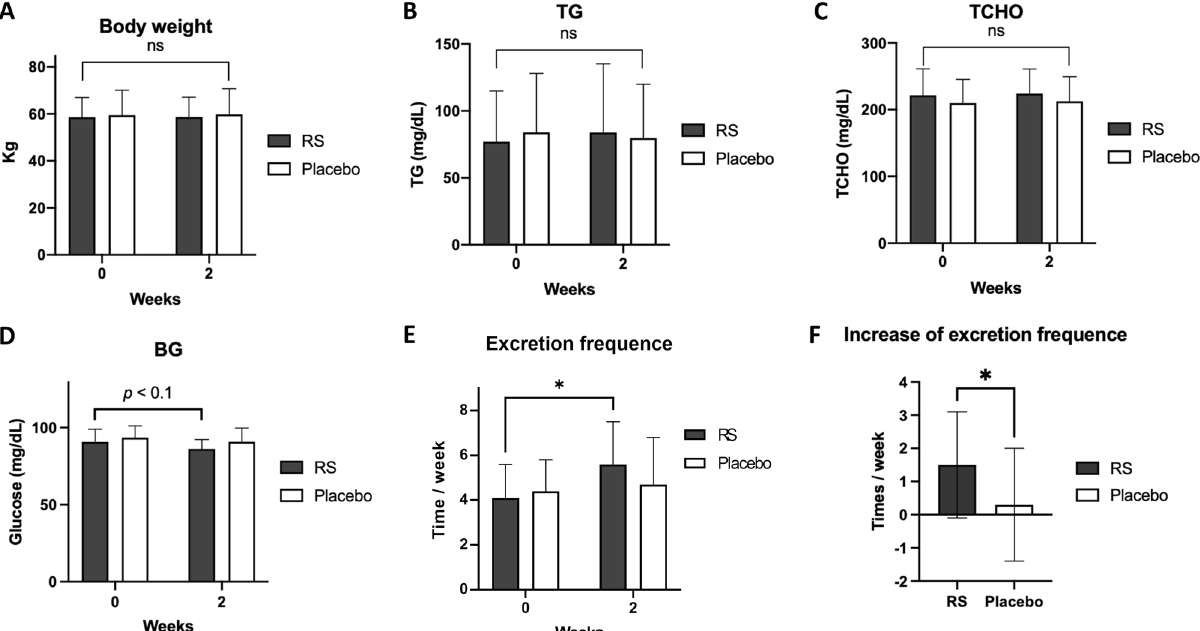
Figure 2. RS increases defaecation in human subjects. ( A ) Body weight change during the trial. ( B–D ) Plasma triacylglycerol (TG; ( B )), total cholesterol (TCHO; ( C )) and blood glucose (BG; ( D )) at Weeks 0 and 4. ( E,F ) RS increased in faecal frequency at Week 2. * p < 0.05, ** p < 0.01. n = 19, error bars indicate